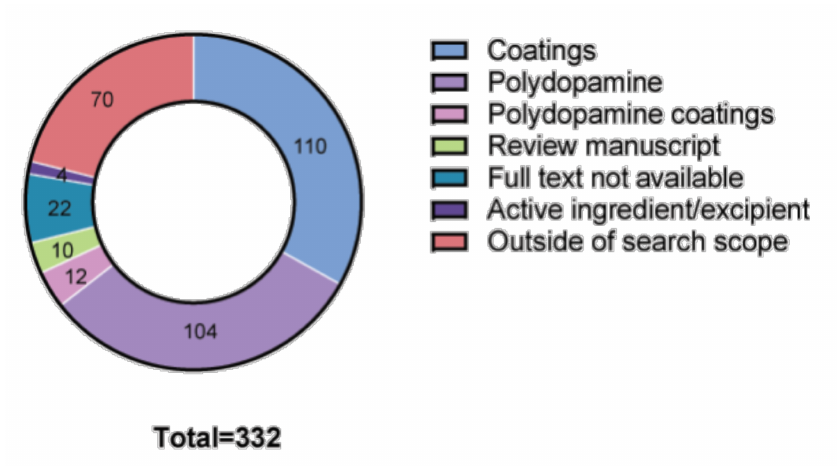
Figure 6. Graphical illustration of the manuscripts excluded during initial abstract